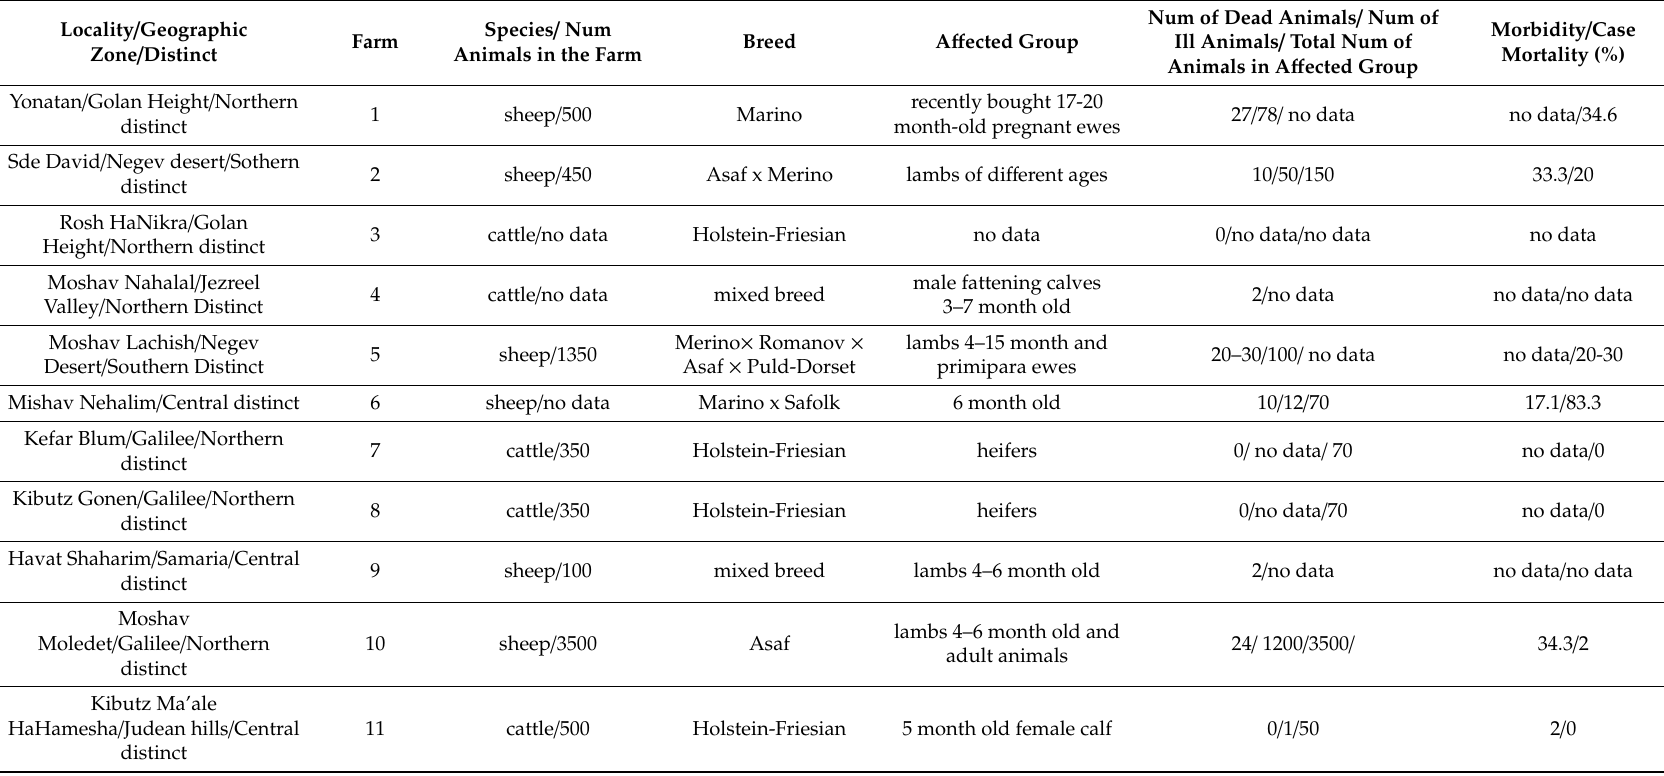
Table 3. Localities and epidemiological aspects of sheep and cattle farms, where BTV-6 was identified. Locality /